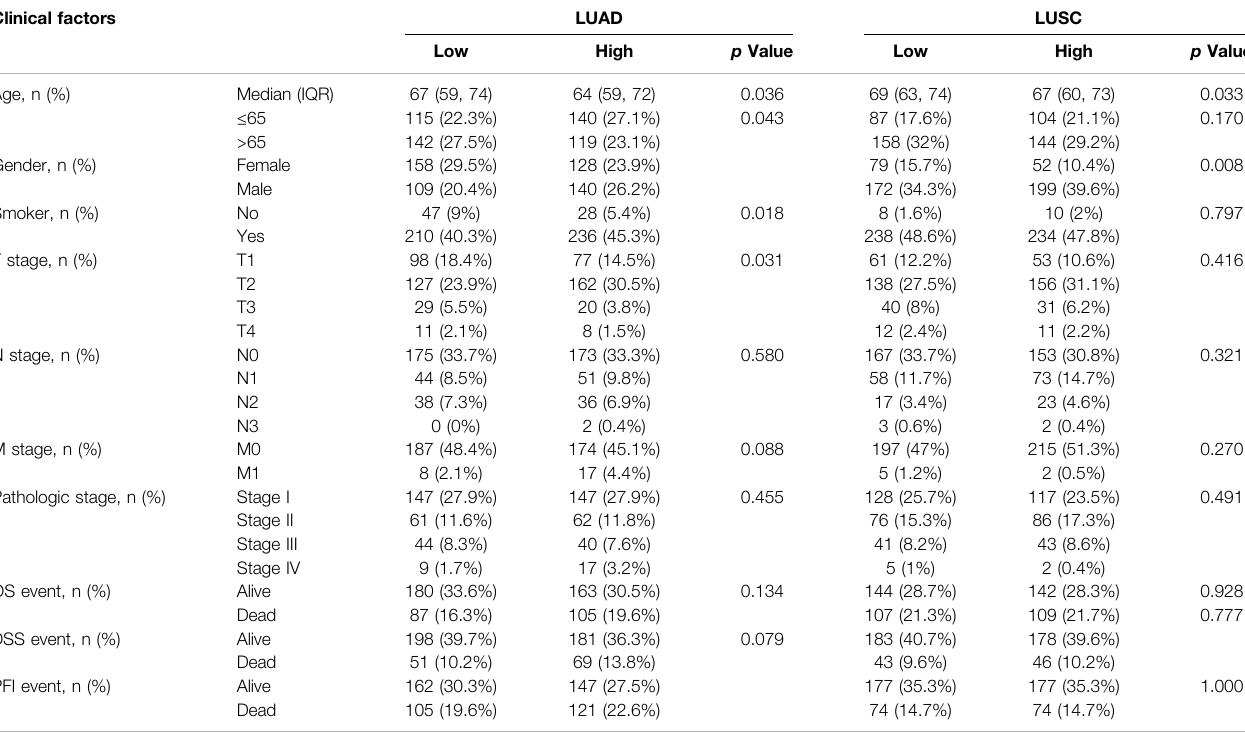
TABLE 1 | Clinical characteristics of lung adenocarcinoma (LUAD) and lung squamous carcinoma (LUSC) patients with FANCD2 high or low expression based on TCGA database. Clinical